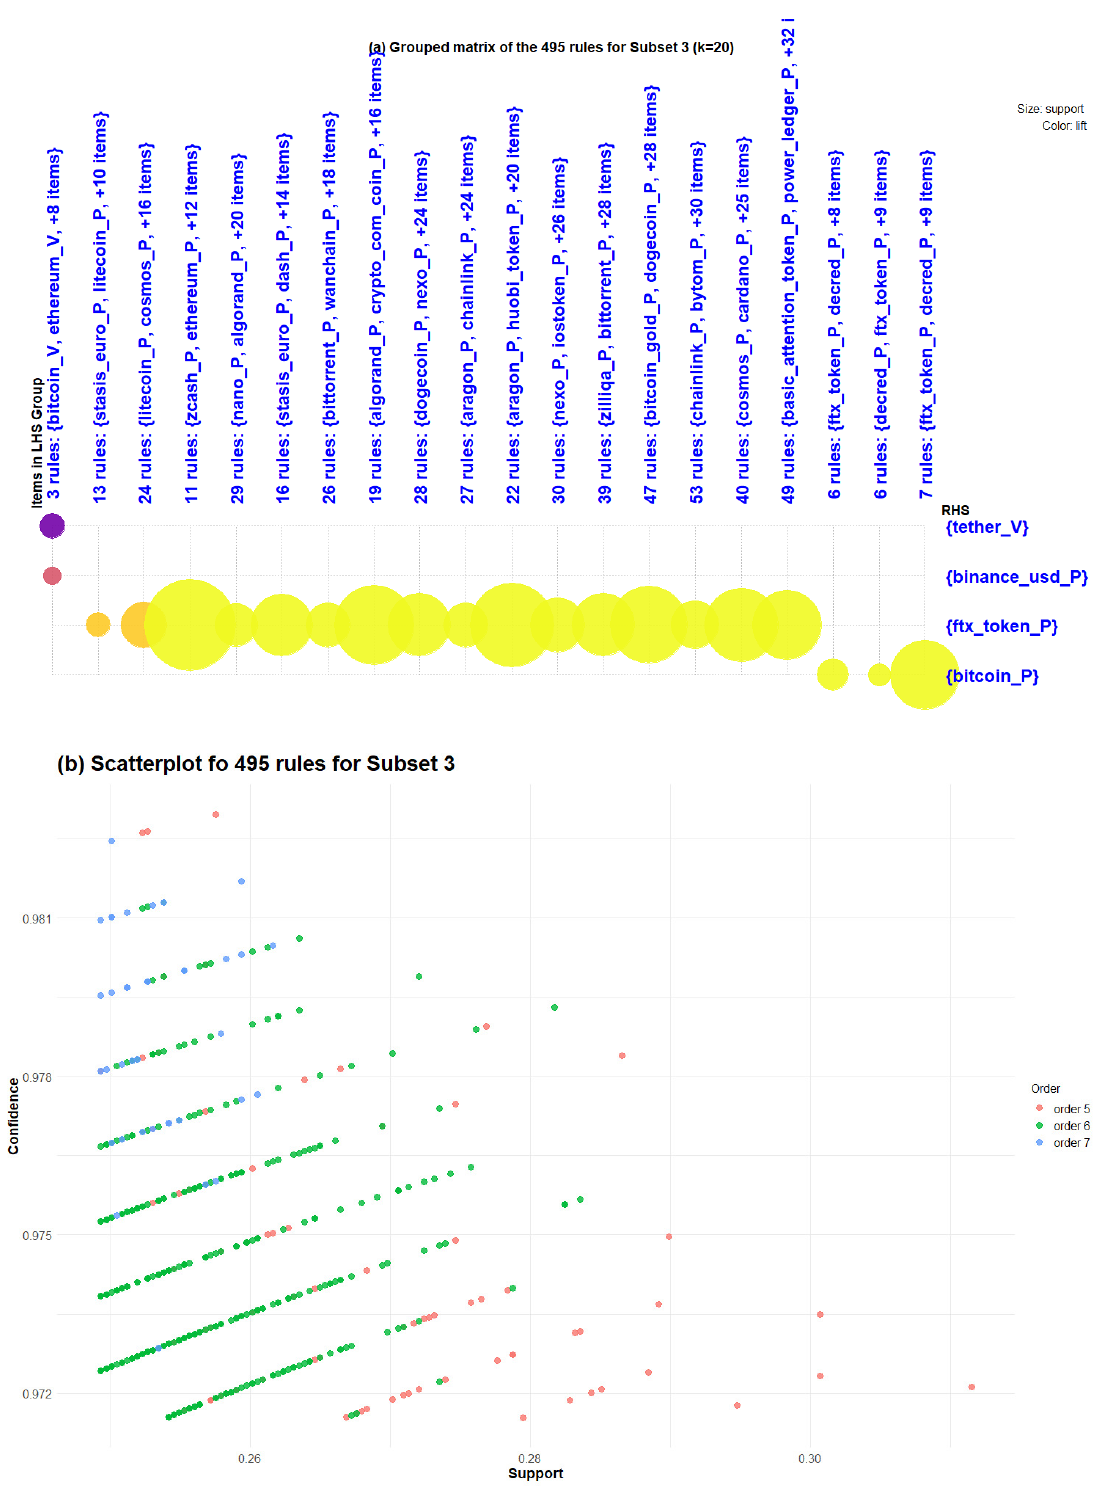
Figure 7. ( a ) Group matrix-based plot for 495 rules of Subset 3 with k = 20 groups, ( b ) Scatter plot of the rules for Subset 3 colored by order (LHS +